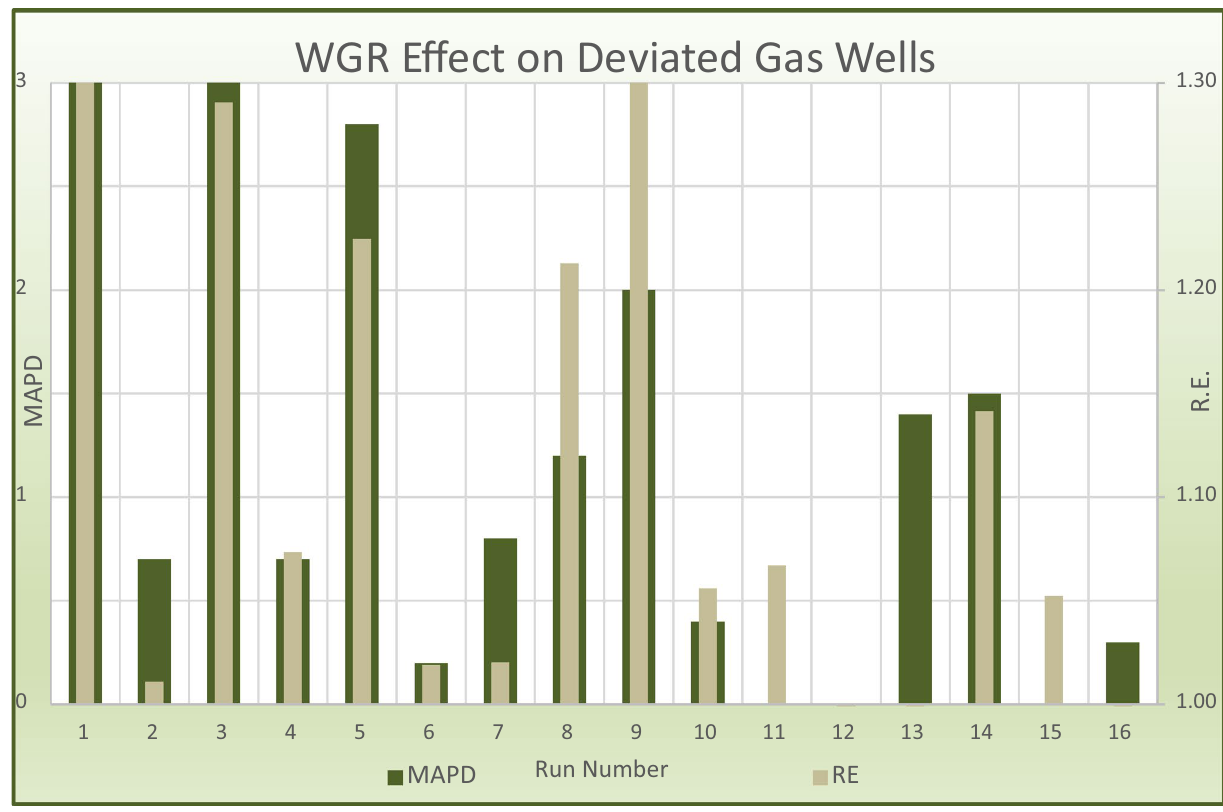
Fig. 4 Effect of WGR on deviated wells using MAPD and RE